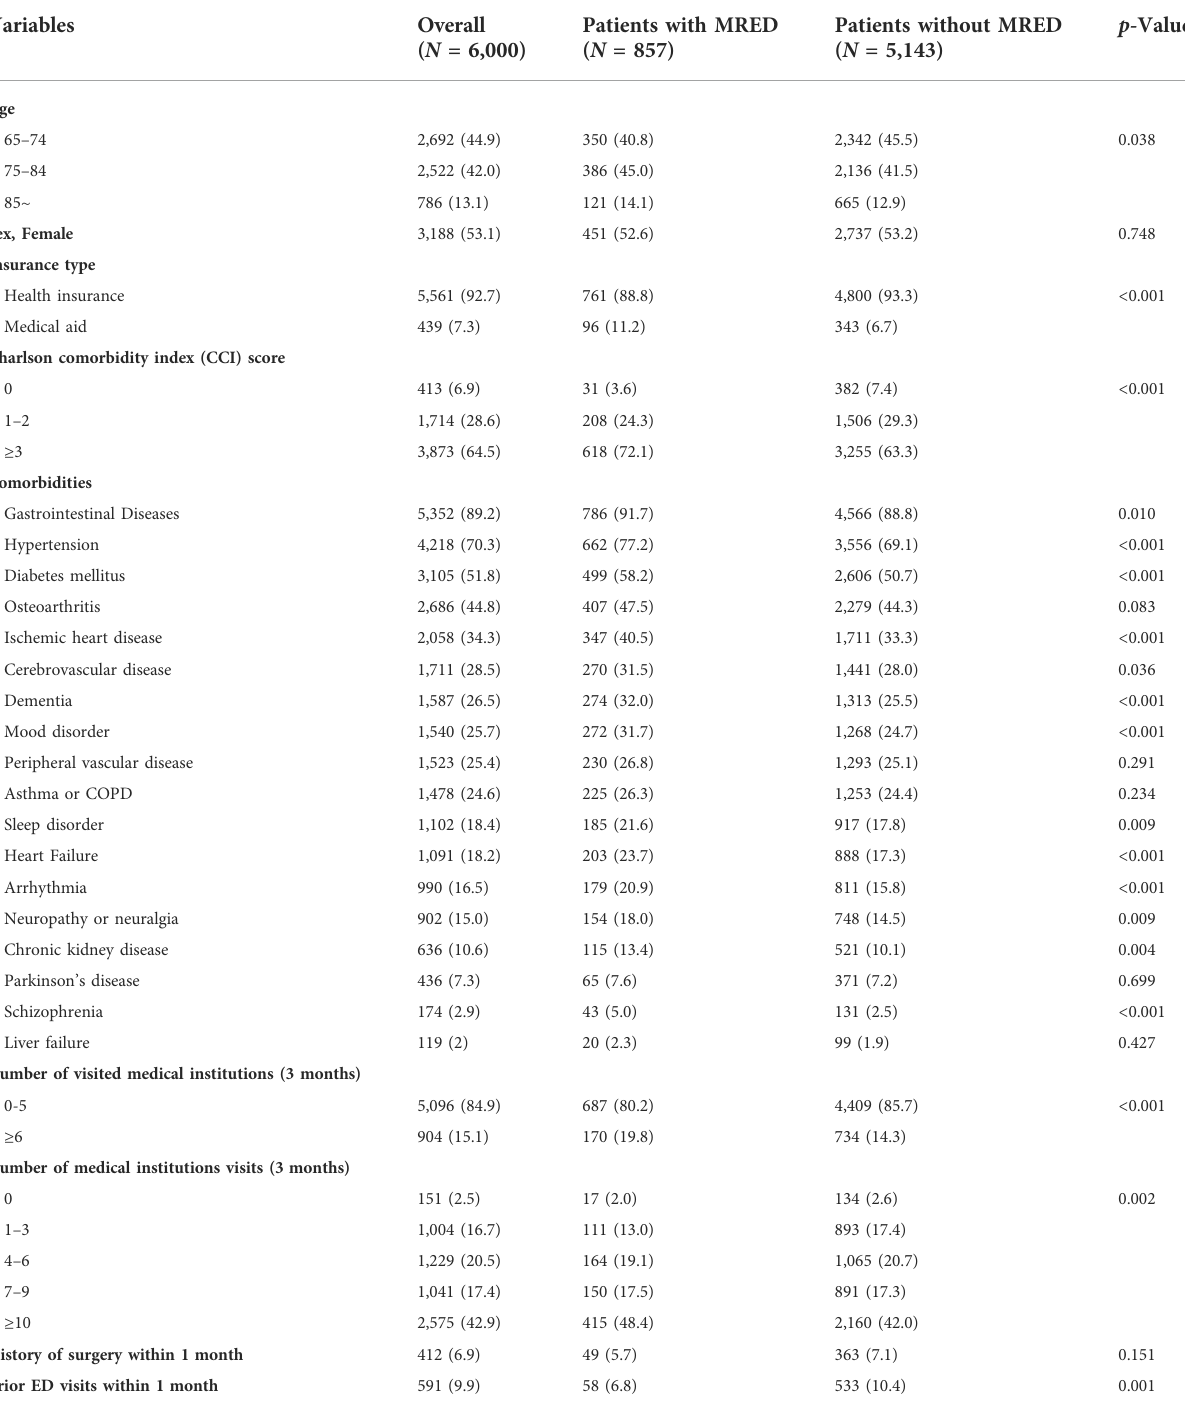
TABLE 1 Characteristics and medication use pattern of the study